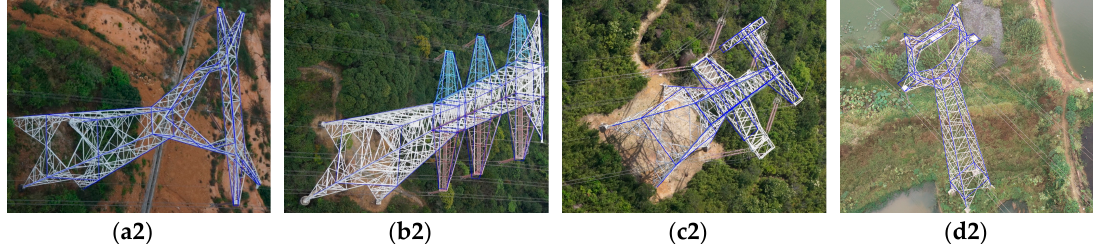
Figure 12. Samples of four type pylon reconstruction results. ( a – d ) are the reconstructed pylon models of Type 1, Type 2, Type 3 and Type 4, respectively. The second and third rows are the projected model from different image perspectives.